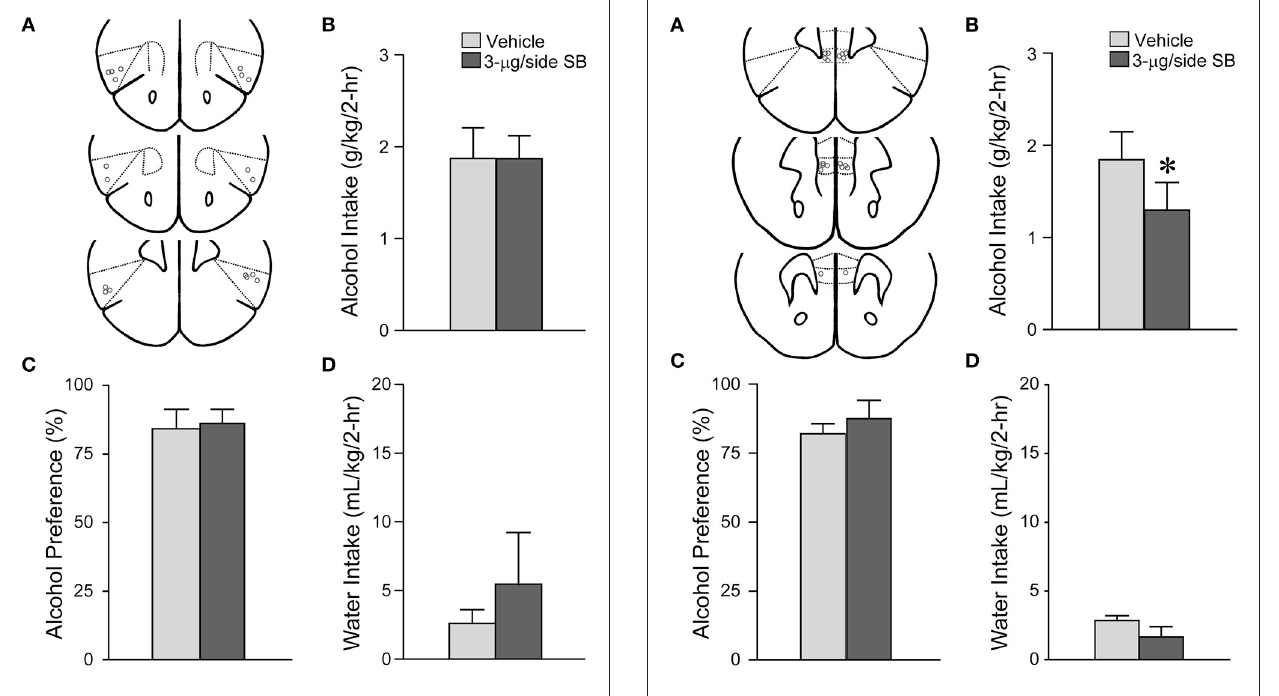
FIGURE 5 | OX1R blockade in the anterior Insular cortex did not alter alcohol drinking. (A) Locations of cannulae shown by gray circles; sections at approximately AP + 2.22, + 2.10, and + 1.98mm relative to Bregma. (B–D) Infusion of 3- µ g SB within the aINS did not alter (B) alcohol intake, (C) preference, or (D) concurrent water intake.